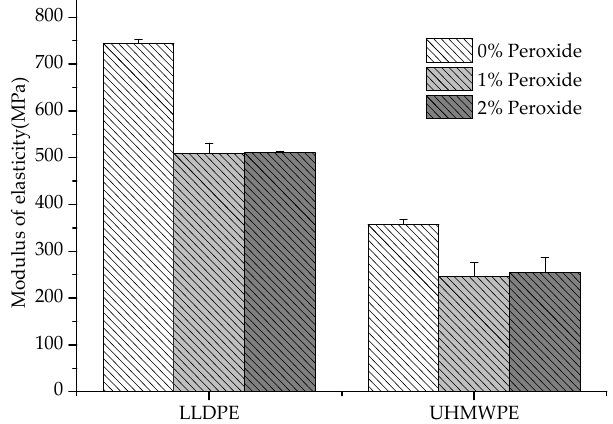
Figure 7. LLDPE and UHMWPE elastic modulus with 1% and 2% peroxide.